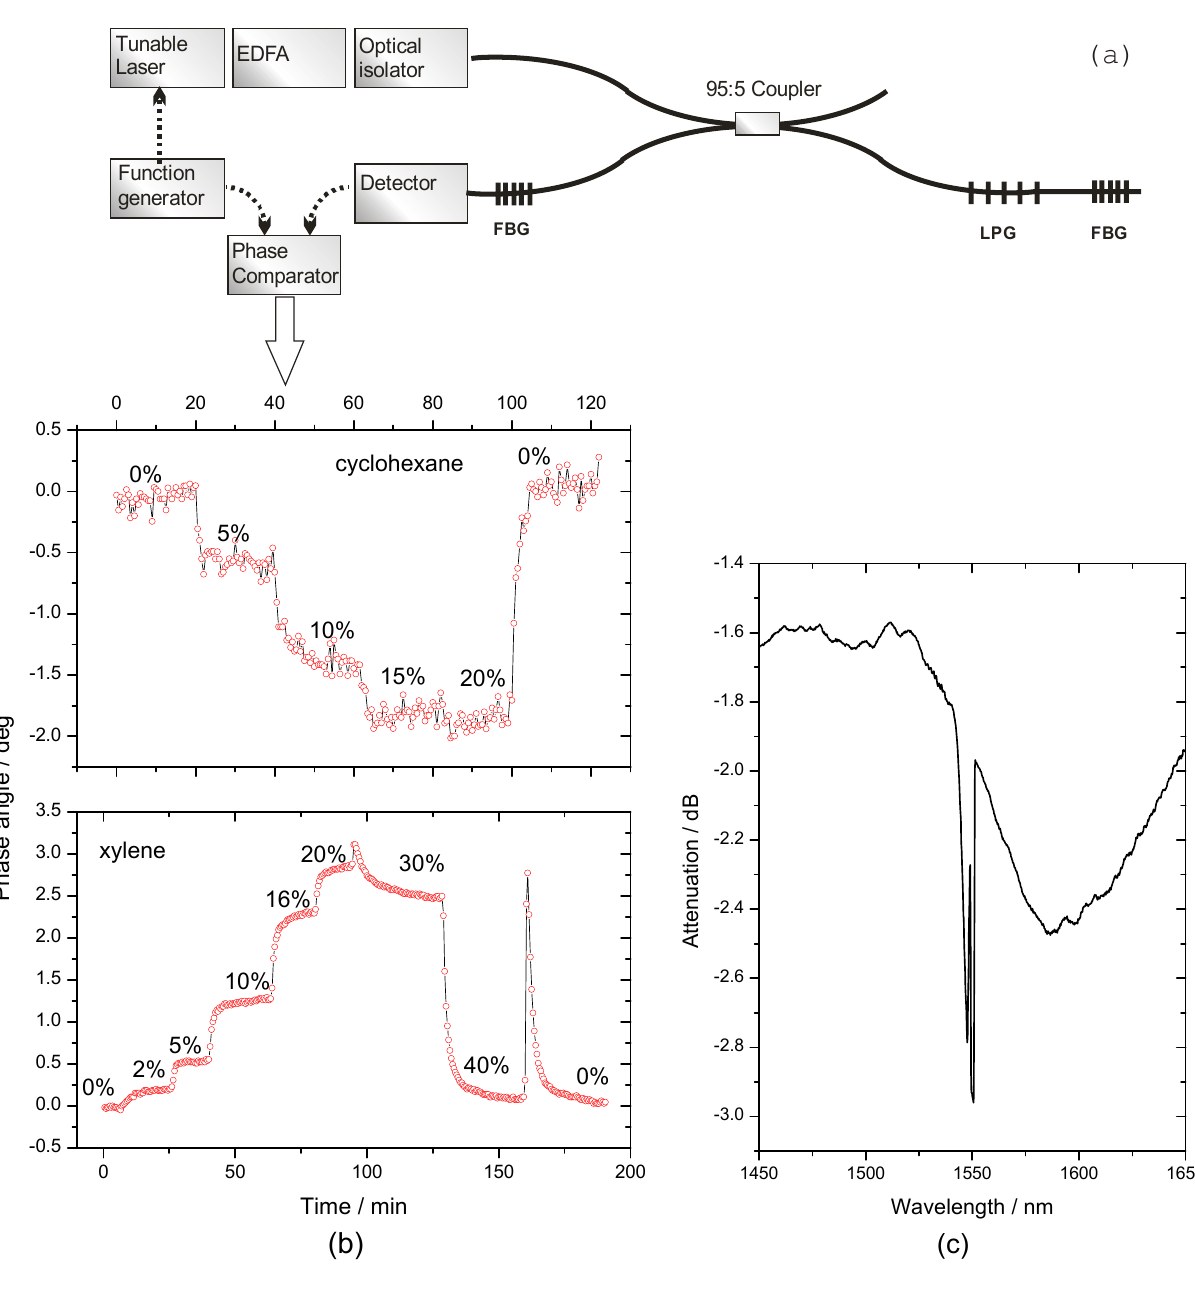
Figure 8. Fiber cavity ring-down for quantification of xylene and cyclohexane using a polydimethylsiloxane / polymethyloctylsiloxane coated long-period grating as a refractive index sensor. (a) Scheme of the experimental setup. (b) Response of the ring-down